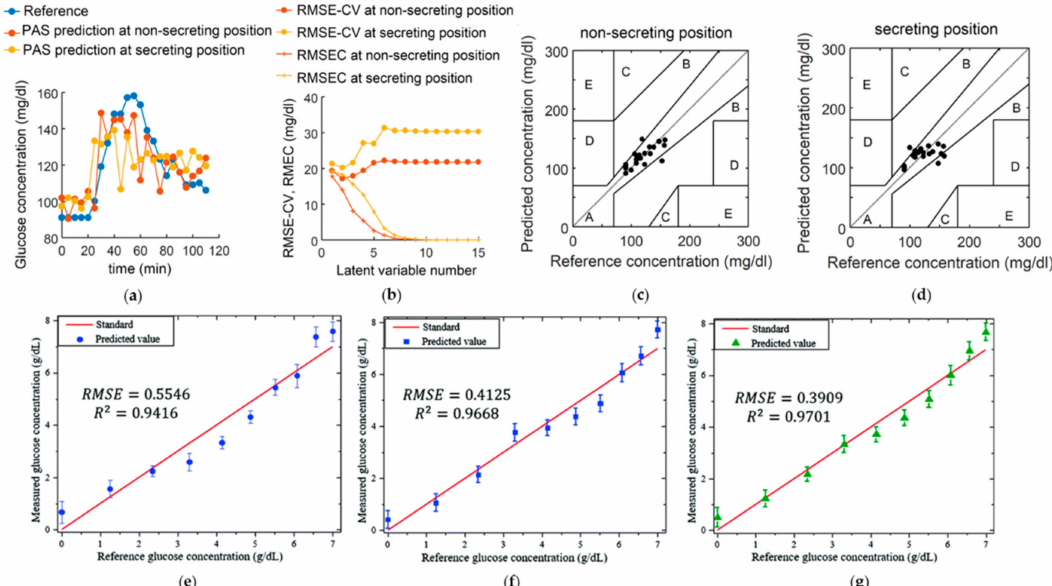
Figure 9. ( a ) PA measured skin glucose on the two different spots of the index finger with or without secretion from an eccrine sweat gland compared with the reference glucose level; ( b ) error analysis with varying latent variable number; ( c , d ) correlation between measured blood glucose and PA predicted glucose from the spectra without ( c ) or with ( d ) the secretion from a sweat gland; ( e – g ) correlation between predicted glucose concentration and reference concentration using ( e ) PA amplitude, ( f ) time delay, and ( g ) data fusion. Reprinted with permission from